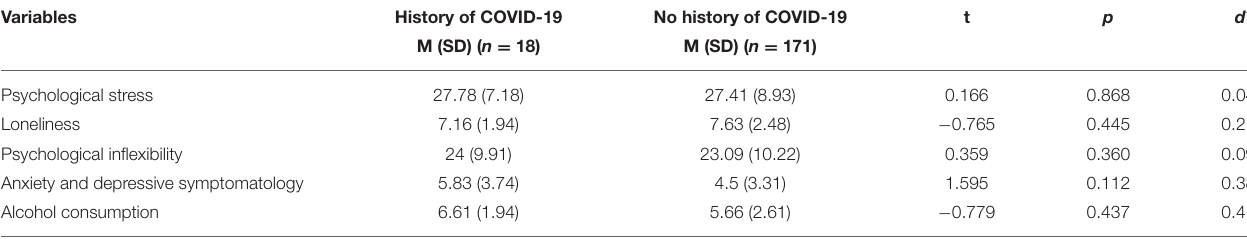
TABLE 3 | Differences in outcome variables by history of COVID-19.